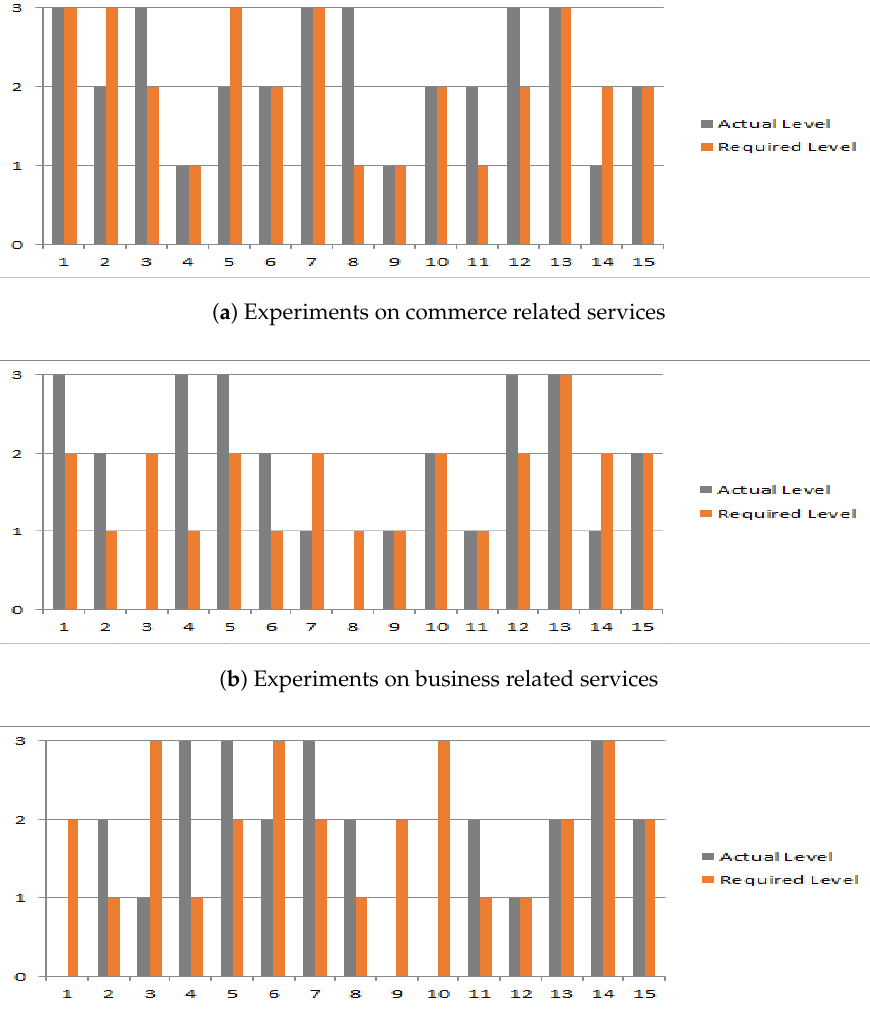
Figure 6. Context aware